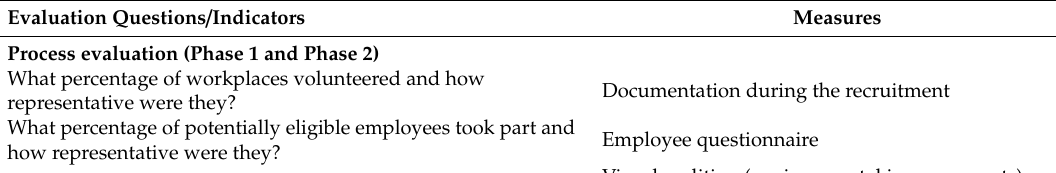
Table 1. Indicators and measures of process and impact